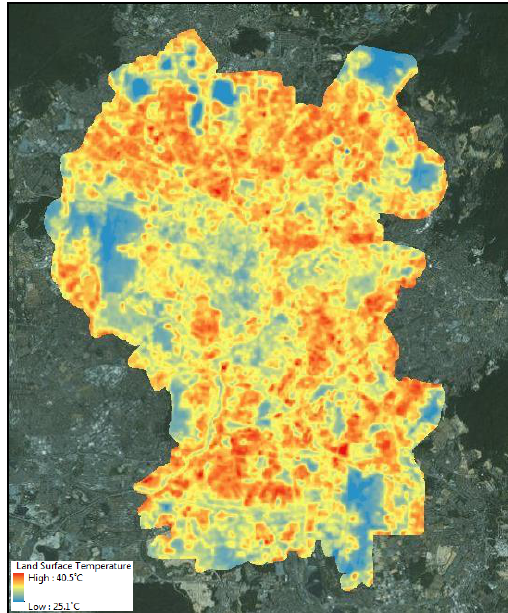
Figure 4. LST distribution in Kuala Lumpur